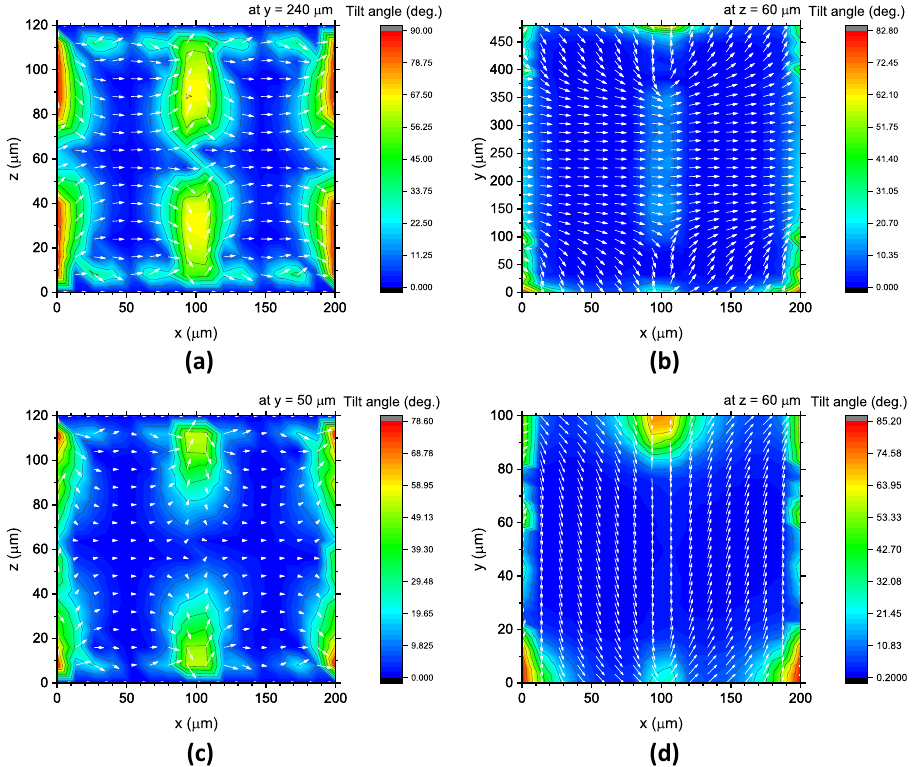
Figure 5. LC director distributions in the unit cells of x : 200 × y : 480 µm (top) and x : 200 × y : 100 µm (bottom); ( a ), ( c ) in the x – z cross-section at the centre of the y -axis, and ( b ), ( d ) in the x – y horizontal-section under the in-plane states of 100 V. The colours indicate the tilt angle from the surface, and the white lines are LC directors.